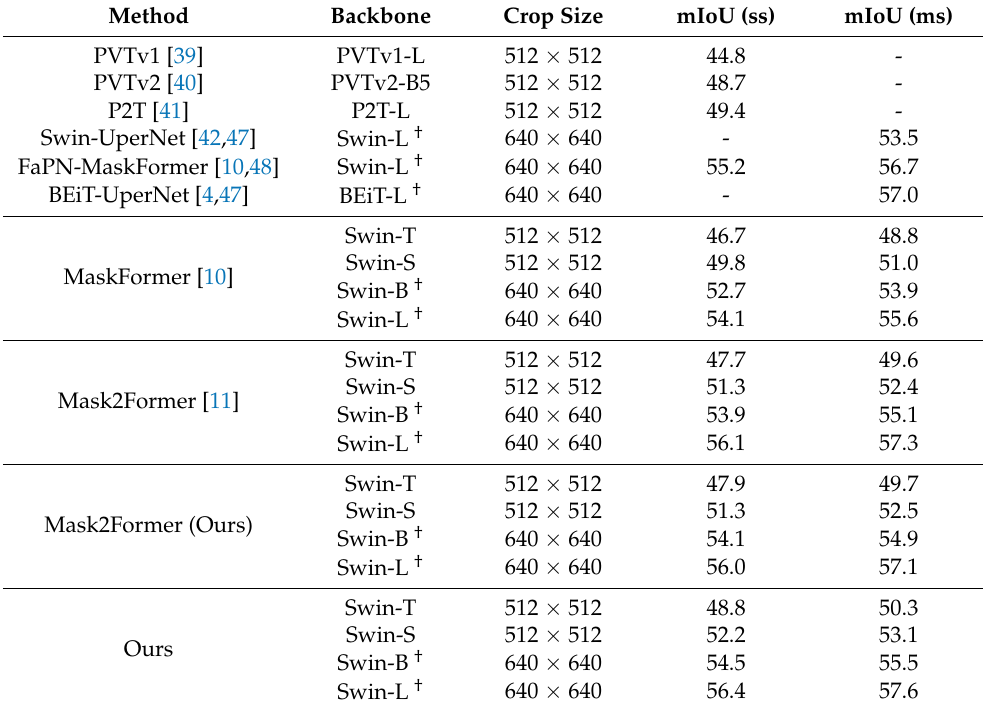
Table 4. Performance comparison of semantic segmentation on the ADE20K validation dataset with 150 categories. †: backbone pretrained on ImageNet-22K. ss: single-scale. ms: multi-scale.